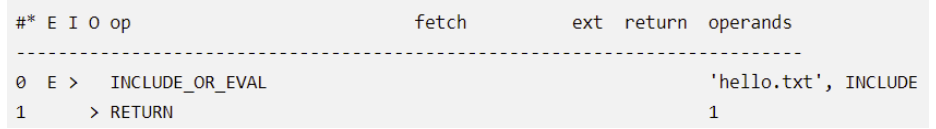
Figure 4. The Opline sequences of webshell1.php. Columns 5 (op) and 8 (return) represent op- code and opline return values. Column 9 (operands) has three values, oprands1, oprands2, and extended_value.